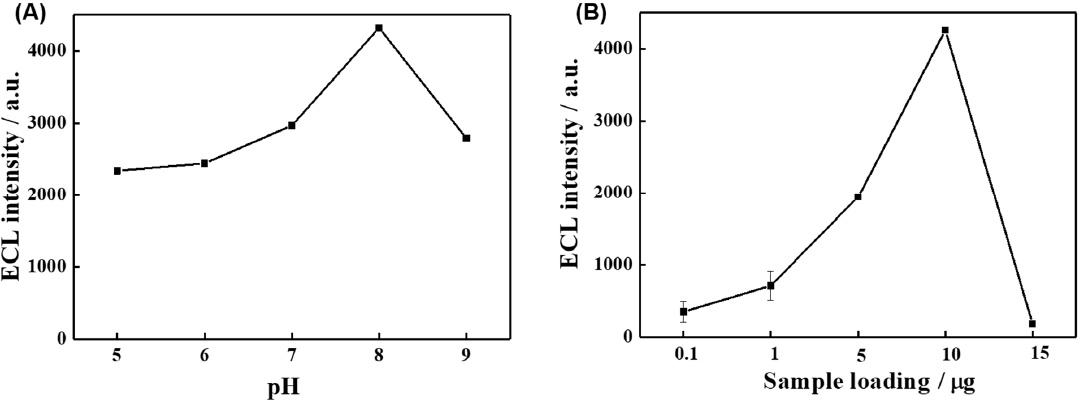
Figure 5. The optimization of ECL experimental parameters. ( A ) Effect of the pH. ( B ) The influence of the weight of sample loading.